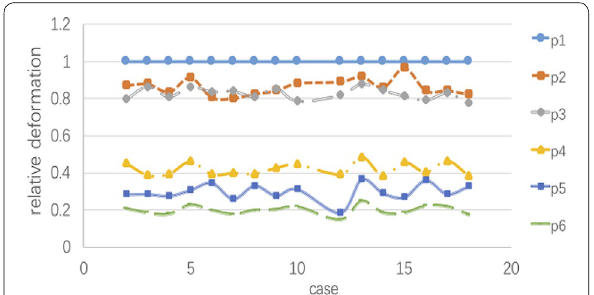
Figure 9 Relative displacement of markers in all